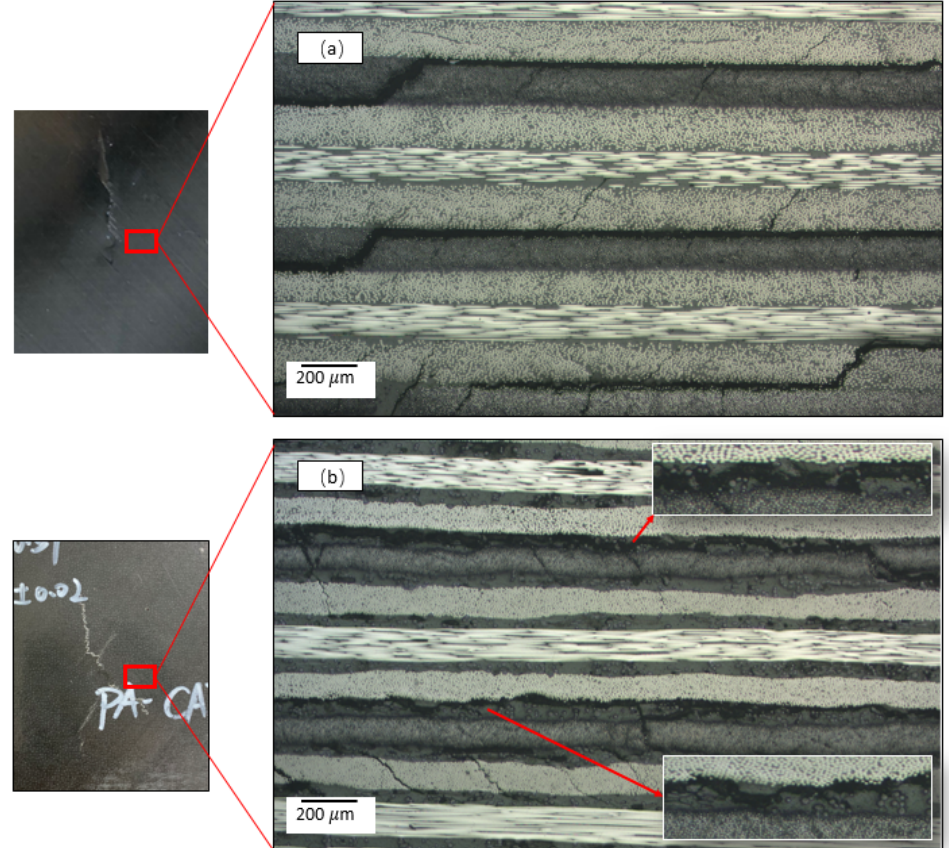
Figure 17. Sectional Observation Near Impact Head Area. ( a ) Control -CAI , ( b ) NVIC -CAI .